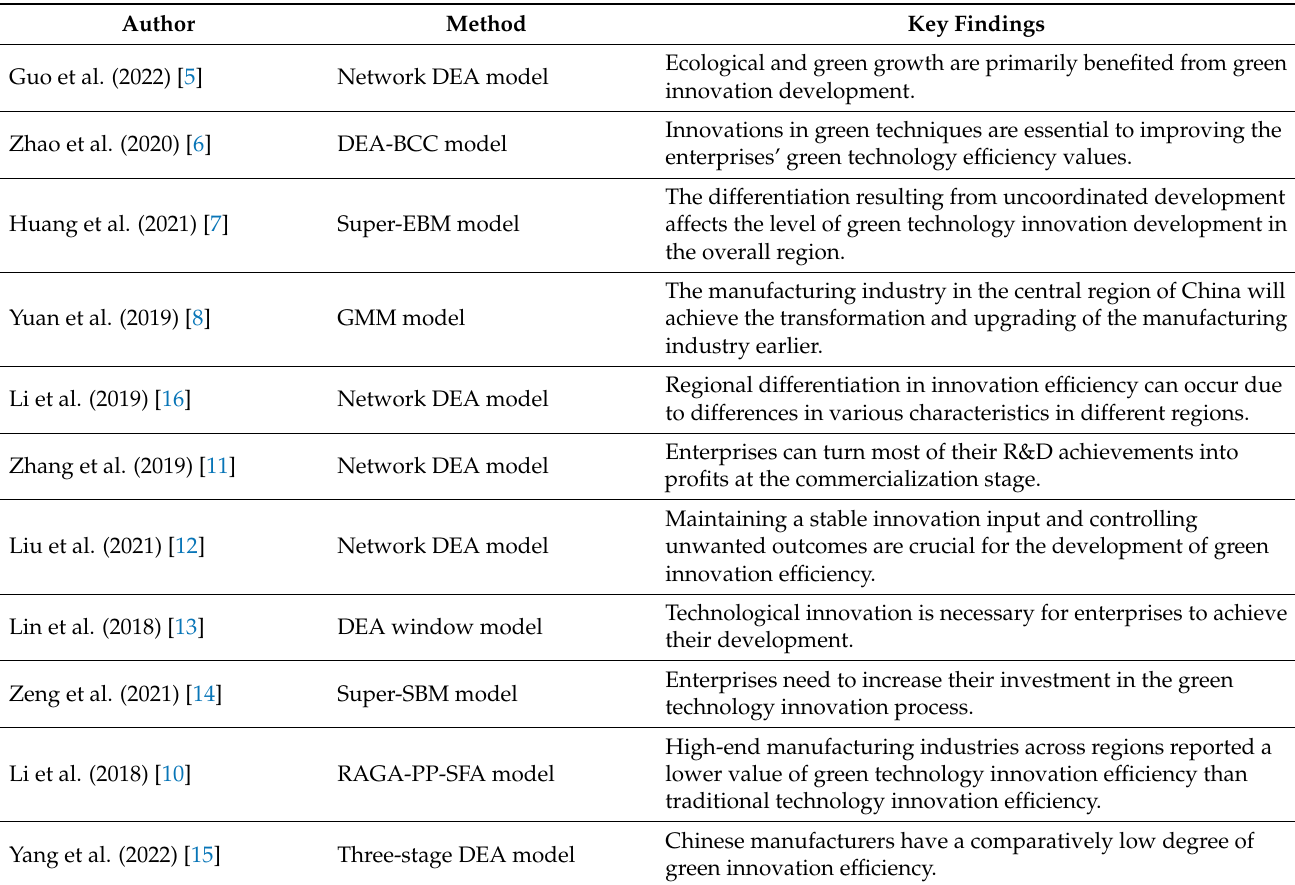
Table 1. Example of studies on green technology innovation